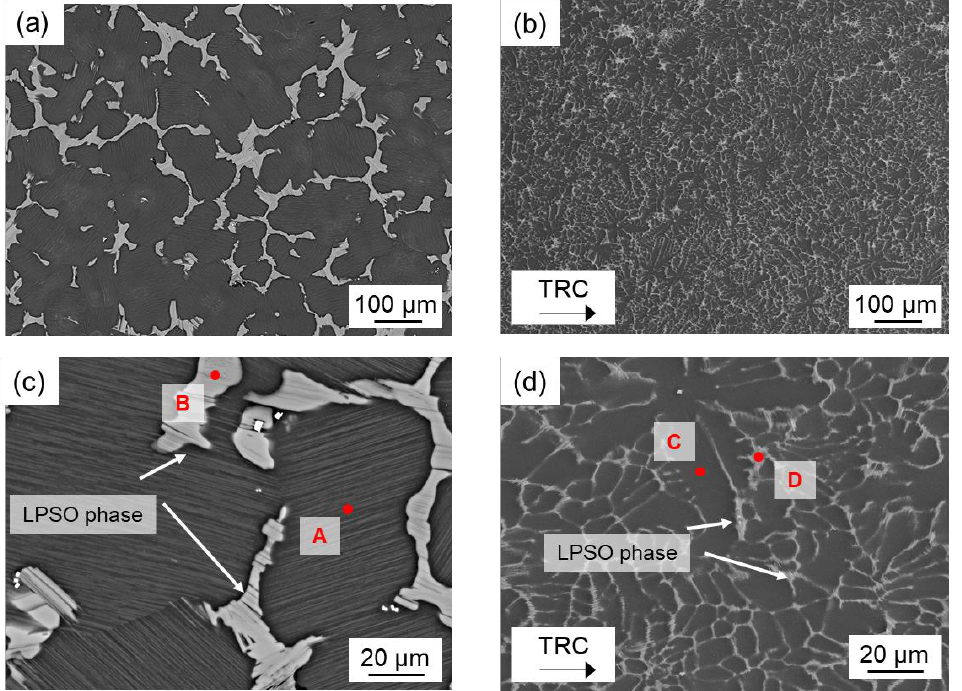
Figure 2. SEM images of the homogenized (500 °C, 2 h) Mg-6.8Y-2.5Zn-0.4Zr alloy: as-cast ( a , c ), (20 kV, AsB) and the TRC ( b , d ), (15 kV, SE) initial states: red points indicate EDX point measurement of the Mg matrix (A,C) and network-like LPSO structures (B,D) .